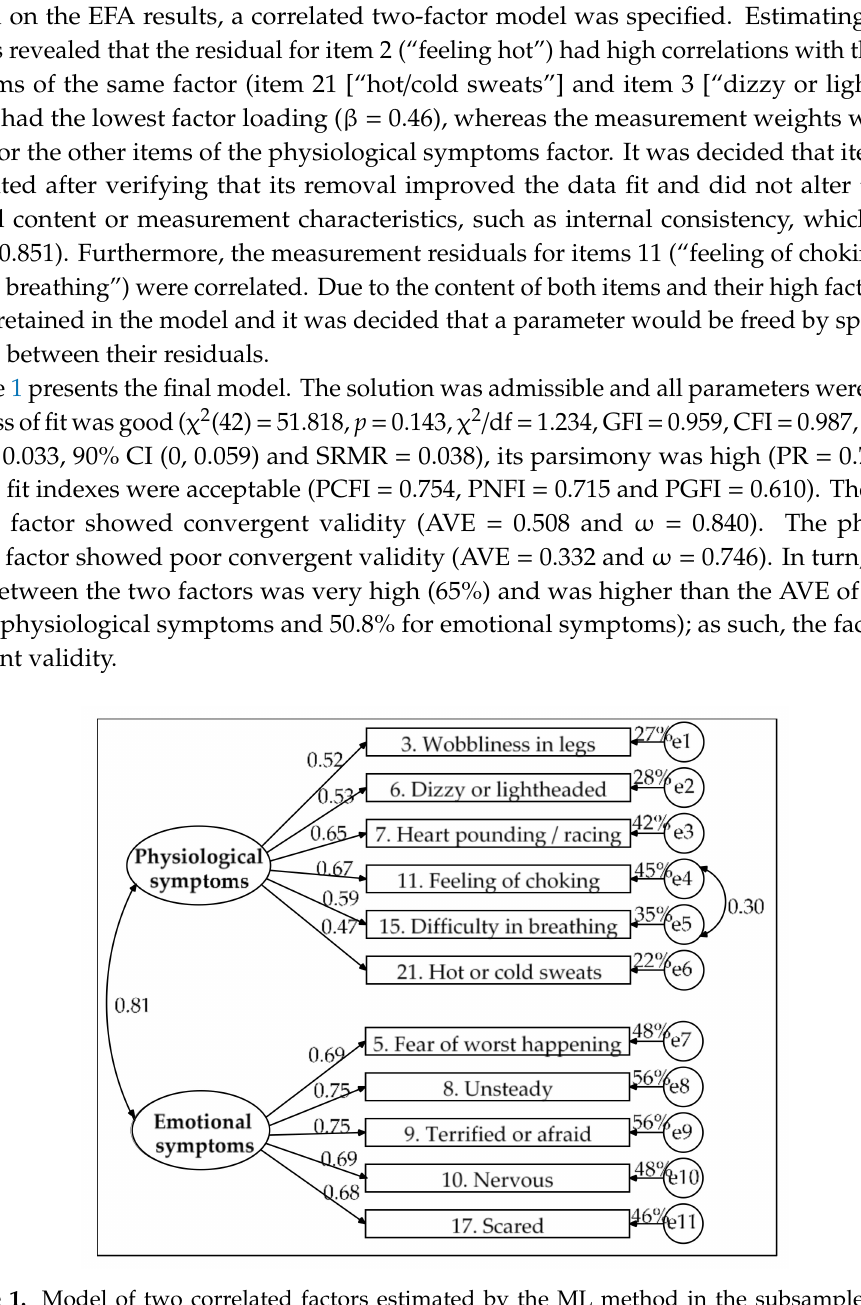
Figure 1. Model of two correlated factors estimated by the ML method in the subsample of 219 participants. Measurement residuals: e1 to